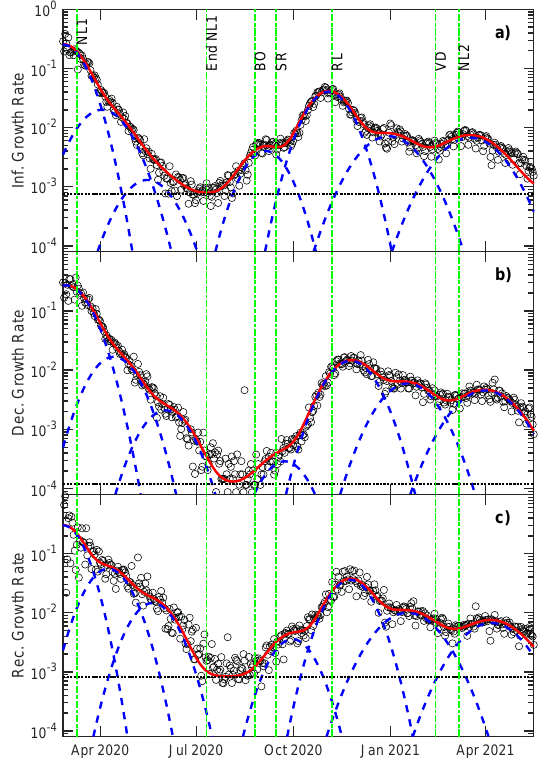
Figure 2. ( a ) Infected, ( b ) deceased and ( c ) recovered growth rate fitted by a Gaussian mixture (Equation (18)) with seven components (blue dashed lines) plus a constant background (black dotted line). The red solid line corresponds to the total fit and the vertical green dashed lines mark important dates as described in the